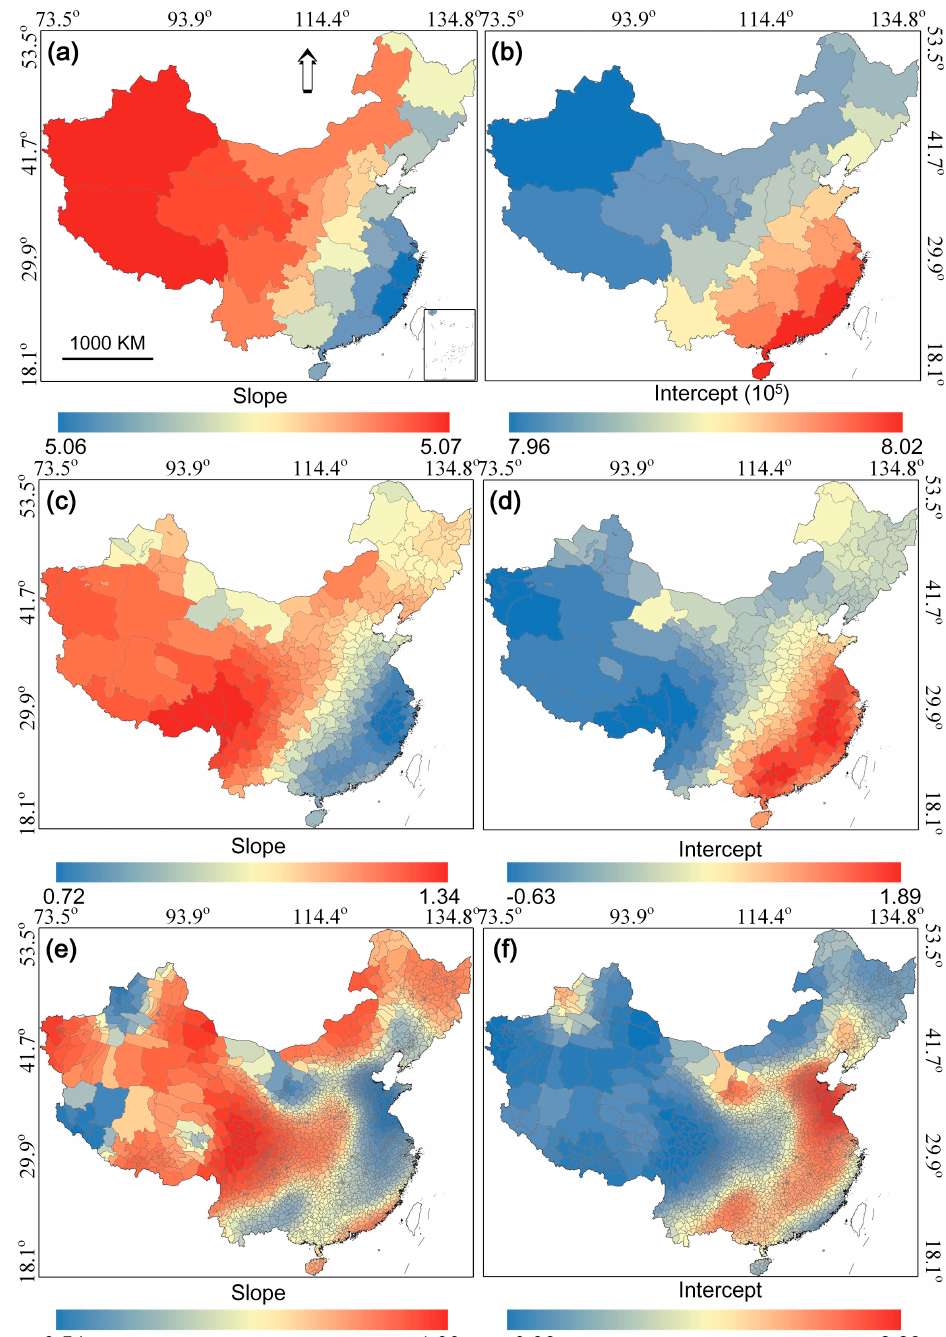
Figure 5. Spatial distributions of the estimated slope ( left, a, c and e ) and intercept ( right, b, d and f ) for the local relationship between the nighttime light radiance and the number of location requests by geographically weighted regression (GWR) at the provincial ( upper, a and b ), the city ( middle, c and d ), and the county ( lower, e and f ) levels across China.